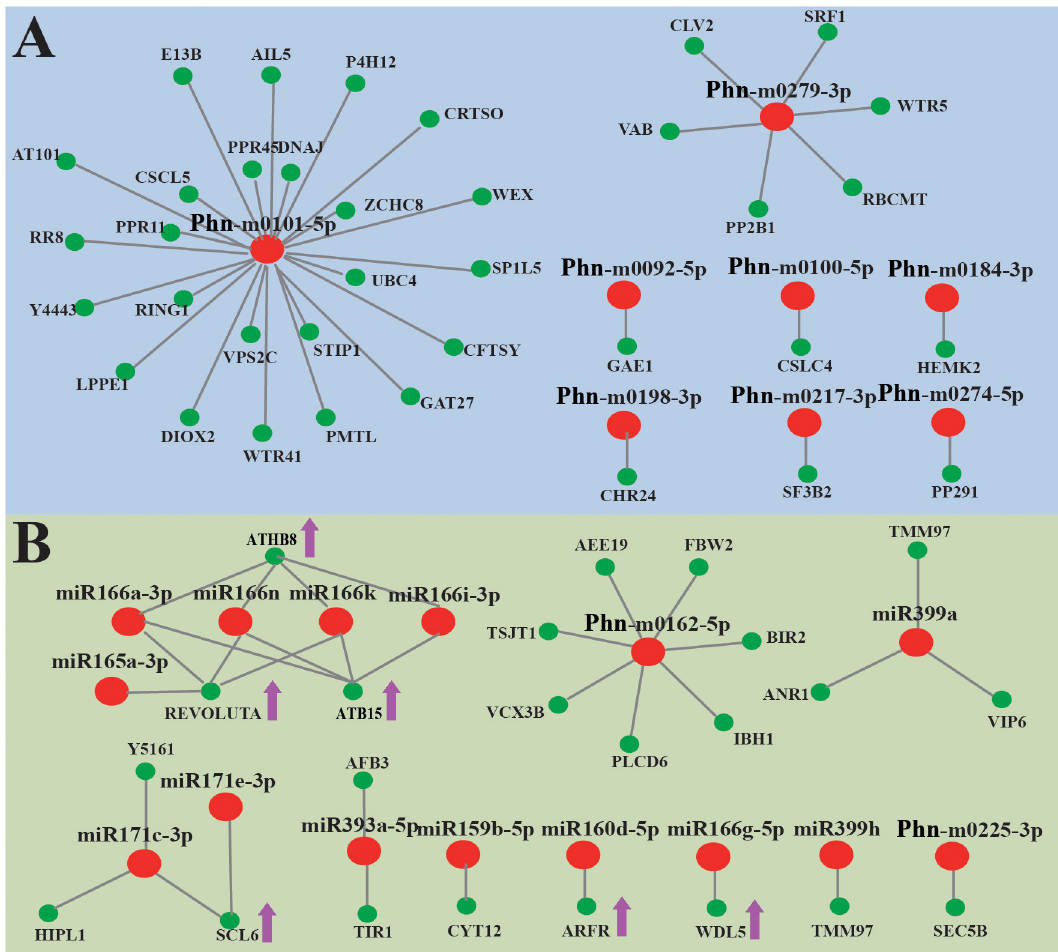
Fig 9. Xylem-special miRNAs in tuberous root and their target genes. (A) A combined view of up-regulated miRNAs in xylem of the tuberous root and their targets; (B) A combined view of down-regulated miRNAs in xylem of the tuberous root and their targets. Pink tip represents significant negative correlation between miRNAs and their target